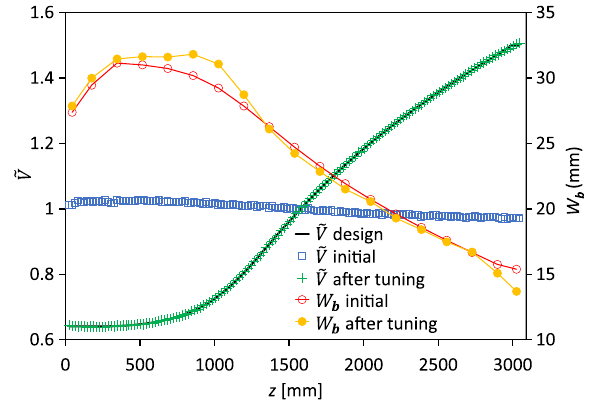
FIG. 5. Normalized V profiles and W b ’ s before and after tuning.